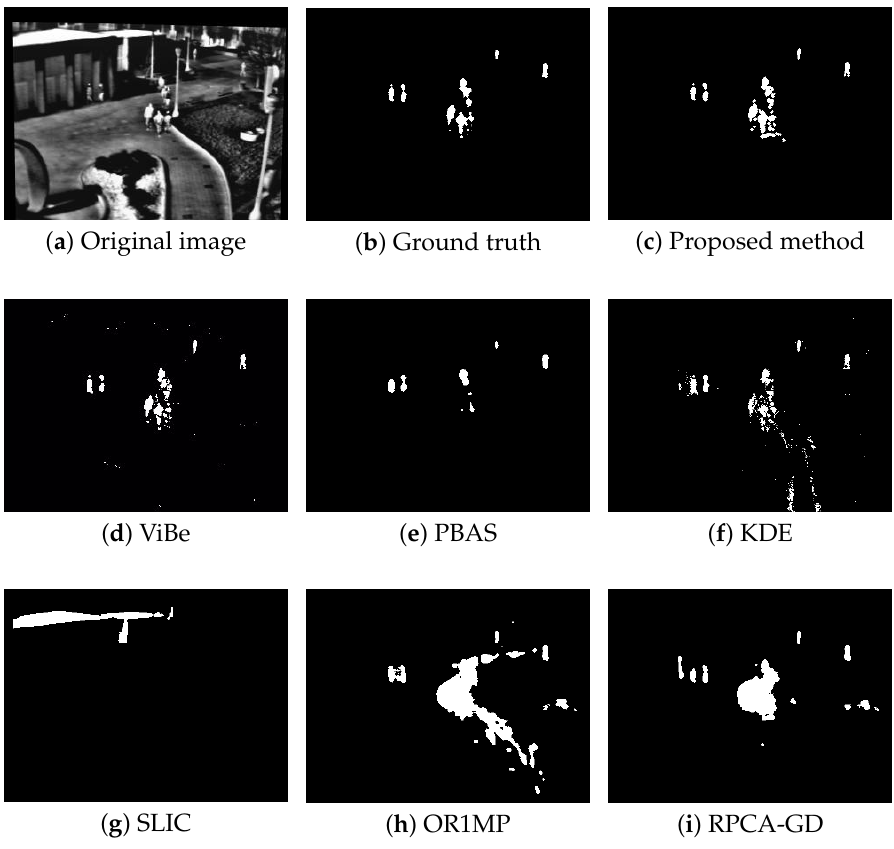
Figure 7. The detection results of the 741rd frame in Seq. 4.